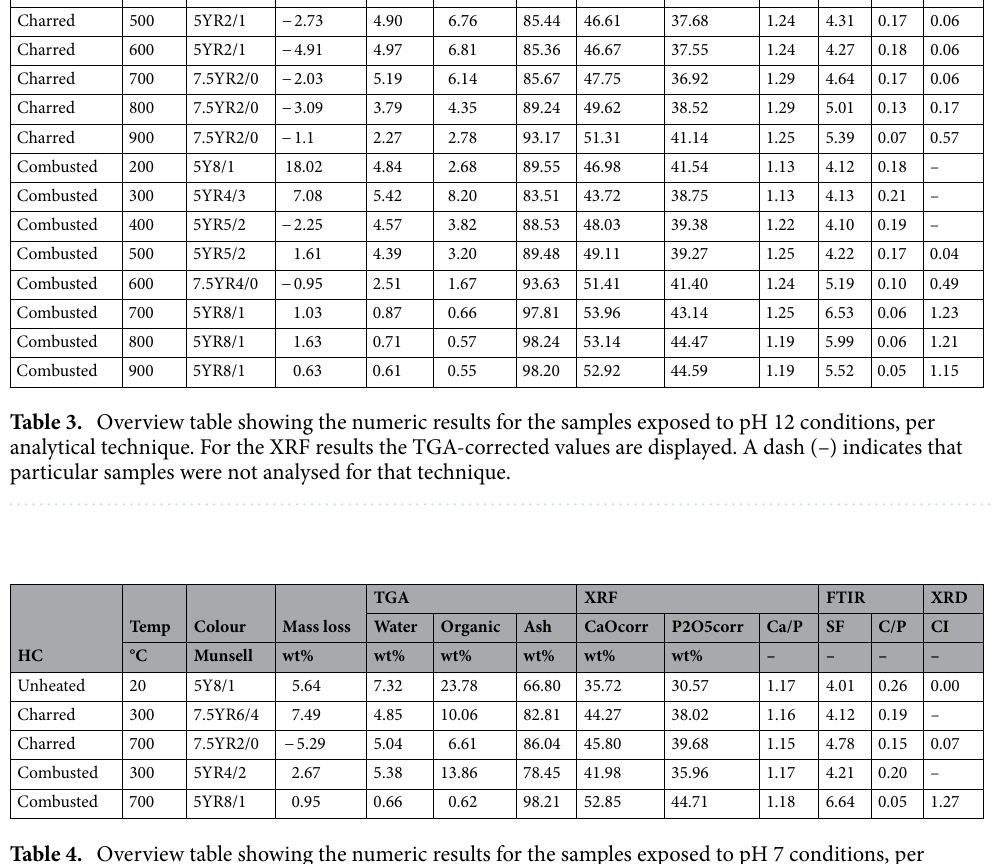
Table 4. Overview table showing the numeric results for the samples exposed to pH 7 conditions, per analytical technique. For the XRF results the TGA-corrected values are displayed. A dash (–) indicates that particular samples were not analysed for that